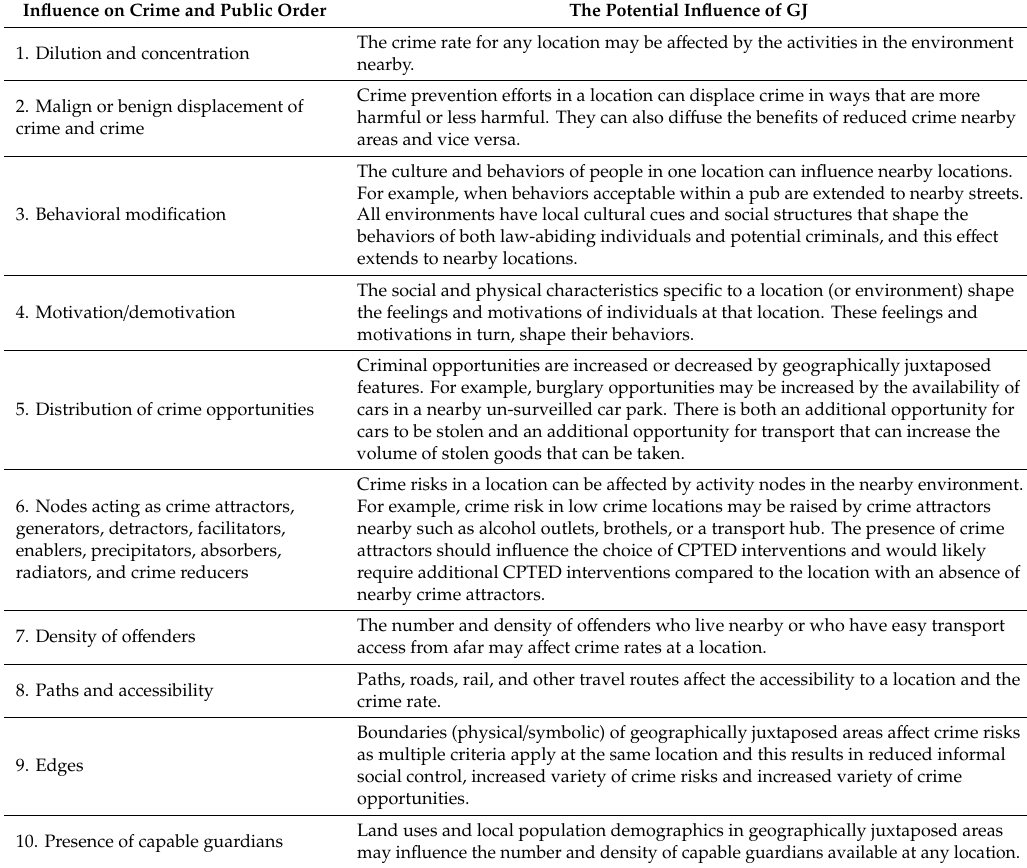
Table 3. Ways Geographical Juxtaposition May Influence Local Crime